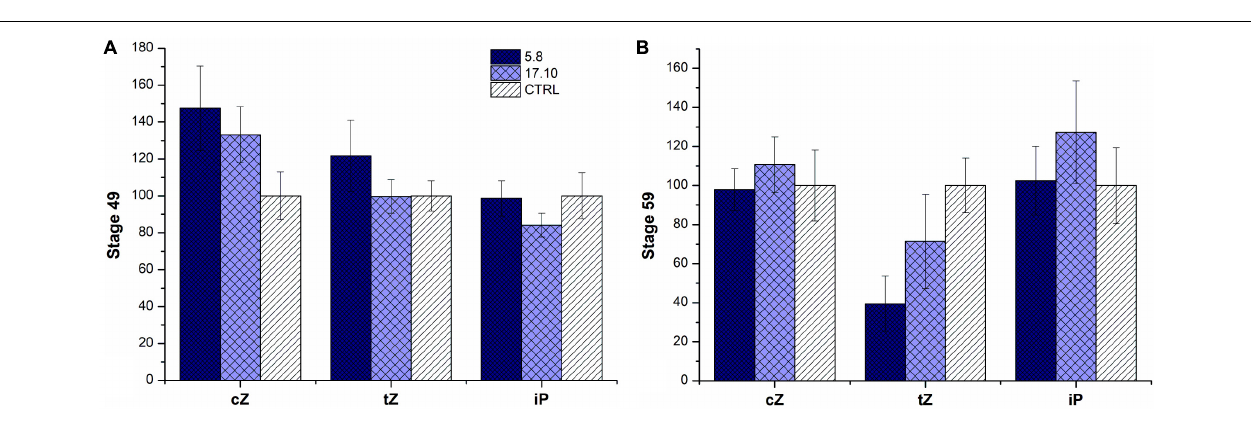
FIGURE 4 | Relative cytokinin content in the spikes of two KD-CKX1 lines grown in the field. Cytokinins were measured in stage 49 [booting: first awns visible (in awned forms only)] (A) and stage 59 (end of heading: inflorescence fully emerged) (B) of two KD-CKX1 lines (5.8 and 17.10). Data are expressed as percentage of the values obtained for the control plants (CTRL) that were set up to 100%. Values are means ± SE. cZ includes cZ free base, cZ riboside and cZ monophosphate; tZ includes tZ free base, tZ riboside, tZ monophosphate and tZ9 -glucoside; iP includes iP free base, iP riboside, iP monophosphate and iP9-glucoside. c Z, cis -zeatin; t Z, trans -zeatin; iP,